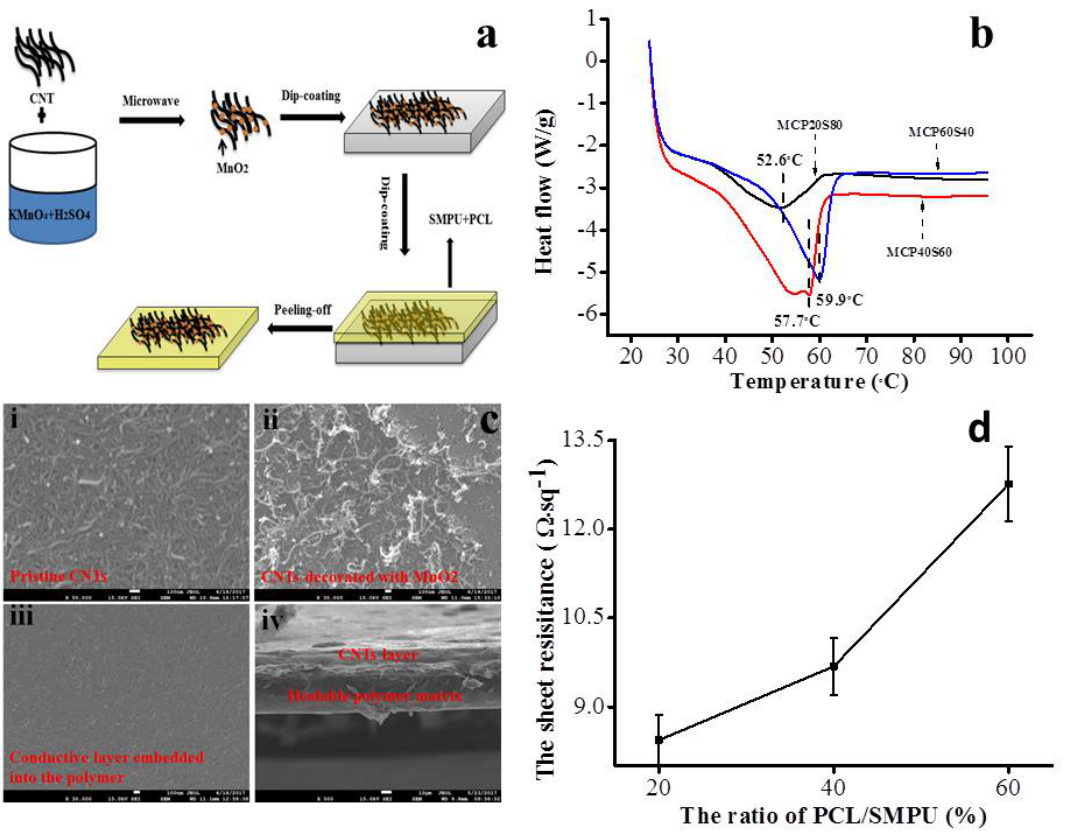
Figure 1. ( a ) Schematic diagram of the fabrication processes; ( b ) DSC curves of the samples with